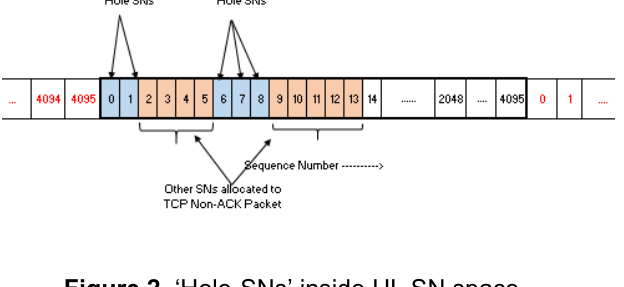
Figure 2. ‘Hole-SNs’ inside UL SN space.